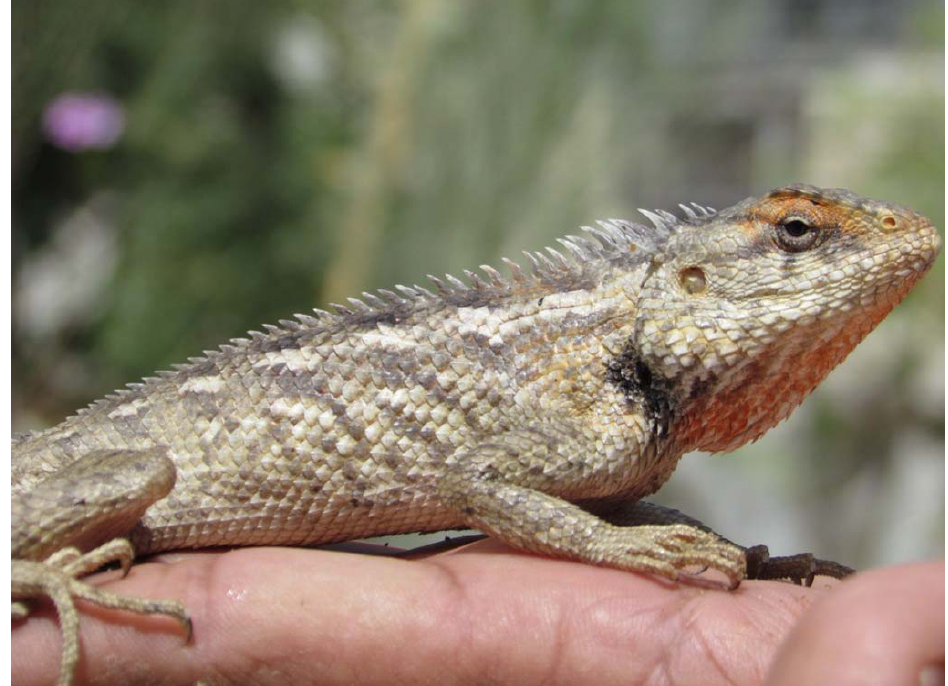
F IGURE 4. The Adult Calotes versicolor captured in Gervani village Sistan and Baluchestan province, Iran (photo by: A. Mobaraki) (ZMGU. 2776, c